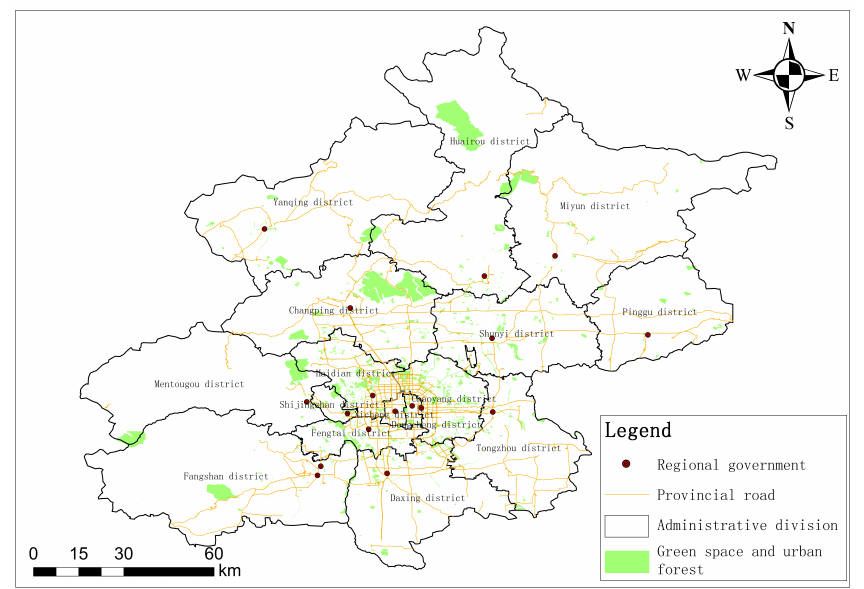
Figure 2. Green spaces and urban forests distribution in Beijing in